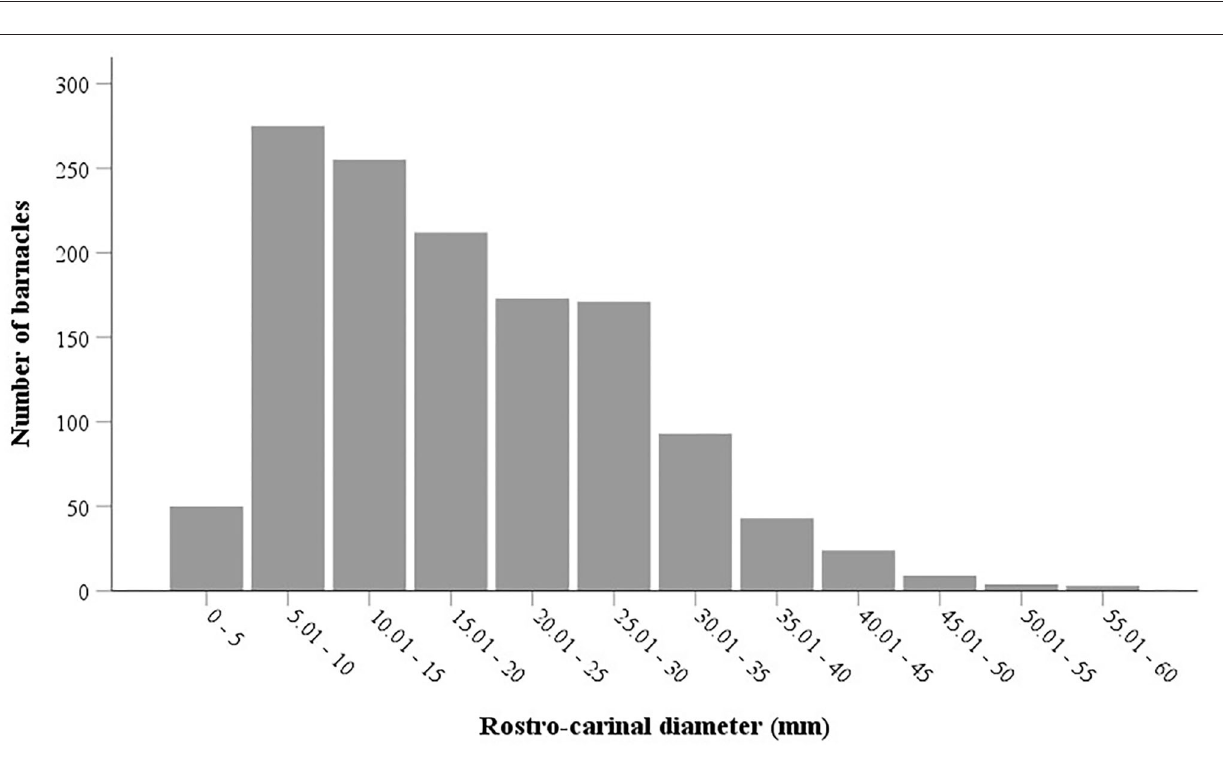
et al., 2014). This mostly includes the short-living taxa such as